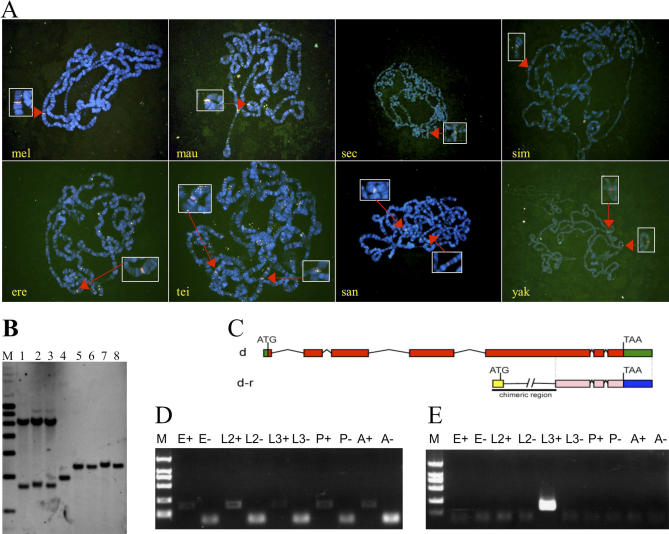
An Example Illustrating the Detection of New Genes(A) The probe LD47348 (CG10595) detected two signals in the clade of D. yakuba-santomea-teissieri while only detecting one signal in other species. The new additional signal suggests a new gene candidate.(B) Southern hybridization results further confirm the extra copy in the D. yakuba-santomea-teissieri clade (M is 1-kb extension marker [Invitrogen]). Lanes 1–8 correspond to Xho I digested DNAs of D. yakuba, D. teissieri, D. santomea, D. erecta, D. melanogaster, D. simulans, D. mauritiana, and D. sechellia, respectively).(C) Cartoon figure displaying the gene structures of the parental gene (d, or CG10595) and the new duplicate (d-r). The duplicated region is indicated by vertical dash lines. d-r recruited one upstream exon as indicated by yellow box.(D) Expression patterns of the parental gene. (E) expression patterns of the new gene d-r revealed by one round of RT-PCR and a second round of nested PCR (M indicates DL2000 DNA molecular marker (Takara); E+, E−, L2+, L2−, L3+, L3−, P+, P−, A+, and A− correspond to positive and negative reactions for embryos, second instar larvae, third instar larvae, pupae, and adults, respectively). From these gels, it is clear that d-r is only expressed in the third instar larvae while the parental copy is expressed ubiquitously. All the bands in the negative control lanes are primer dimer bands. E+ and L3+ are weak but clearly visible.